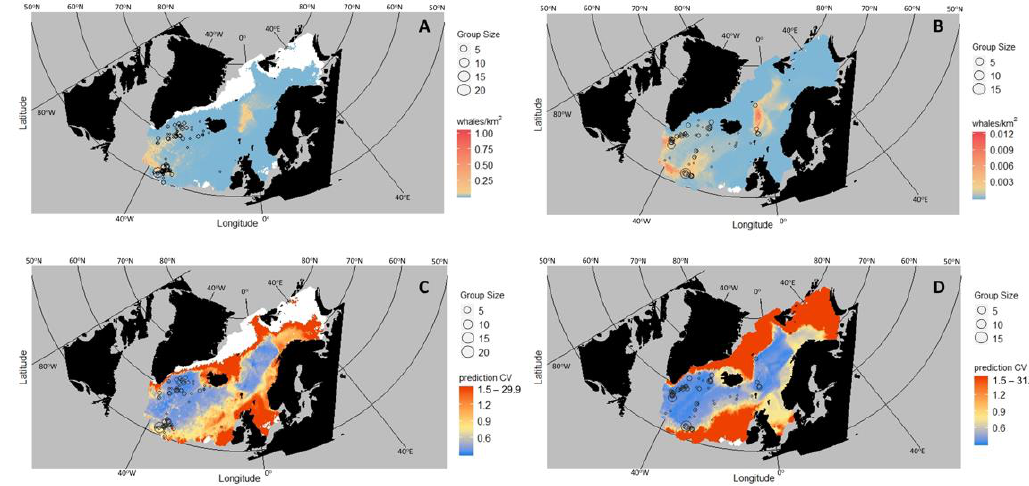
Figure 6. Predicted sei whale distribution based on simple models for 1987-89 (panel A) and 1998-2015 (panel B). White areas are outside predictive space. Panels C and D show the coefficient of variation of predictions in panels A and B, respectively, in which blue shows areas of highest precision. Panels A and C: SST averaged over 1987-1989; panels B and D: SST averaged over 1998-2015. In all panels, the circles show the observed sightings of sei whale groups made over the specified time periods, with size scaled to number of individuals in each